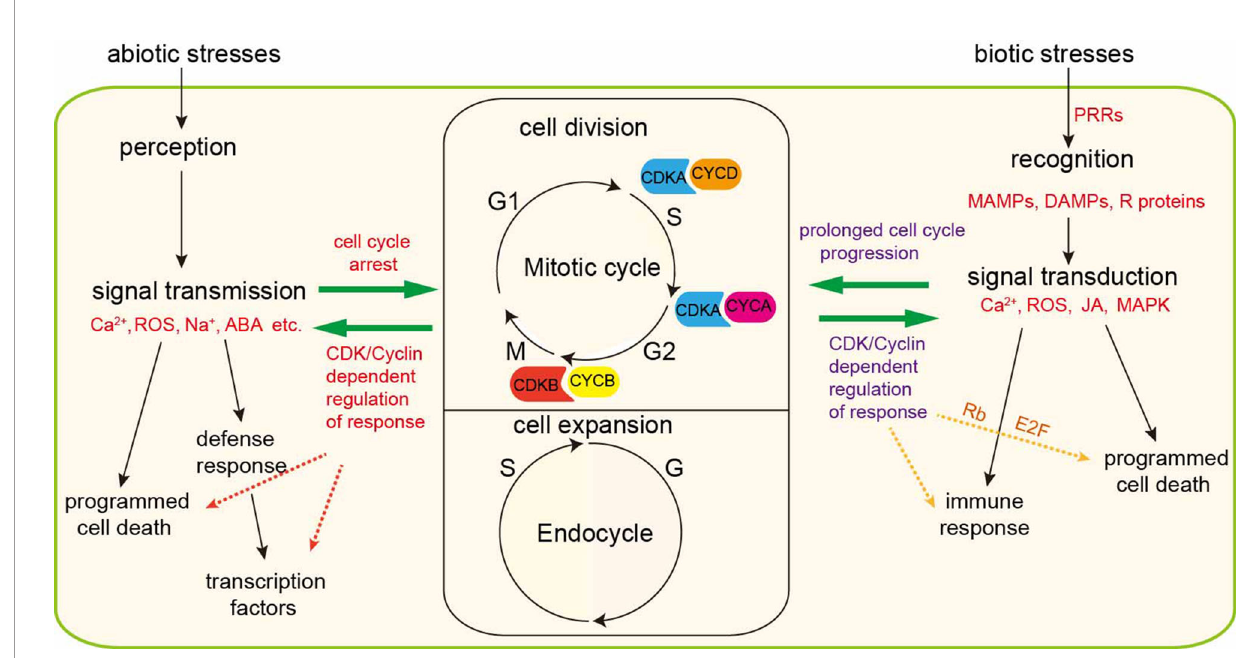
FIGURE 2 | Interactions between stress/response signaling cascades and cell cycle regulation. Plant growth depends on cell division and expansion. Upon biotic stress, cell surface pattern recognition receptors (PRRs) recognize conserved microbe-associated molecular patterns (MAMPs) or damage-associated molecular patterns (DAMPs) or resistant (R) proteins and then transduce primary signal to secondary signal molecules including Ca 2+ fl ux, ROS, jasmonates (JA) and MAPK and eventually initiate immunity. Immune response induces prolonged cell cycle progression or programmed cell death. Overexpression of CDKs or cyclins could enhance immune responses. Besides, G1-S phase checkpoint proteins Rb and E2F engaged in immune-related programmed cell death. Similarly, under abiotic stress conditions, plant cells sense and percept the signals and transmit them to downstream signal molecules, such as Ca 2+ , Na + , ABA, and ROS. These signaling cascades halt cell cycle progression through inhibiting the transcription of CDK/cyclins-related genes. Manipulating the level of CDK or cyclins could change the defense response abilities. Severe abiotic stresses trigger programmed cell